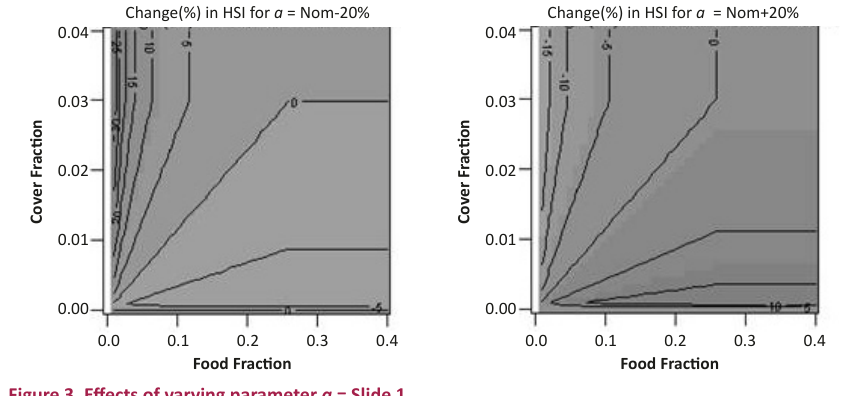
Figure 3. Effects of varying parameter a = Slide